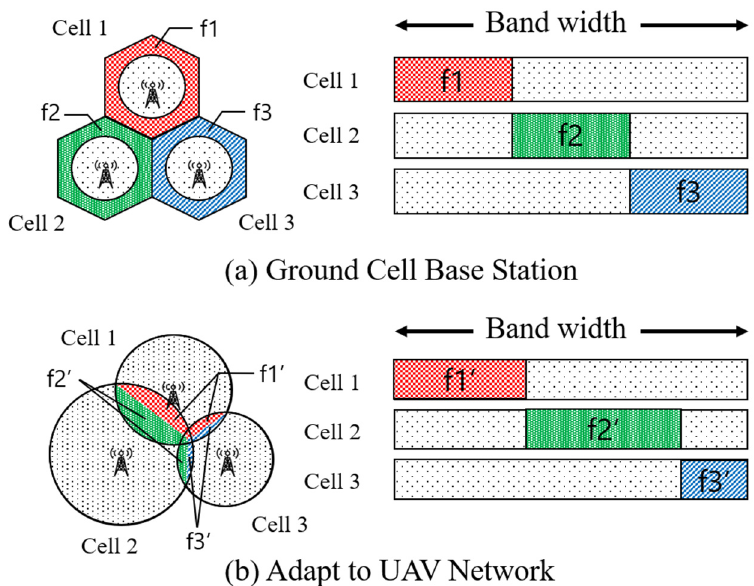
Figure 5. FFR Figure 5. FFR overview.